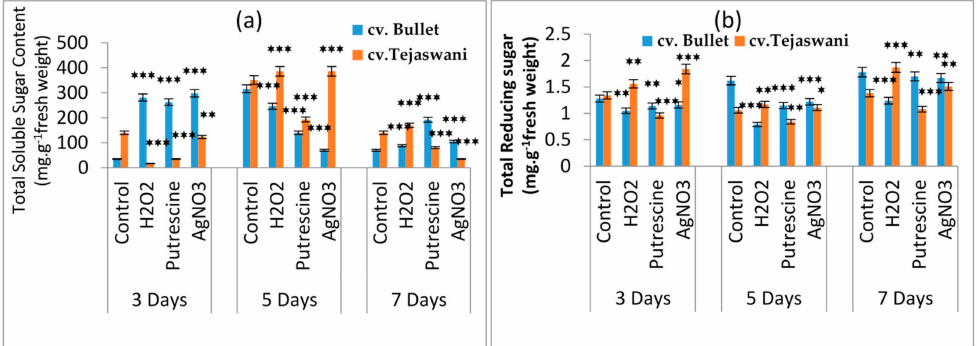
Figure 3. Changes of total soluble sugar ( a ) and total reducing sugars ( b ) of two chili types, i.e., cv. Bullet and cv . Tejaswani, under di ff erent treatments (Control, H 2 O 2 , putrescine, and AgNO 3 ) and durations (3, 5, and 7 days). The vertical bars represent the data with means of three replicates with ± SE ( n = 3) from an individual set of experiments, and significant di ff erences between treatments, as calculated by a student’s t-test marked as * ( p ≤ 0.05) ** ( p ≤ 0.01) *** ( p ≤